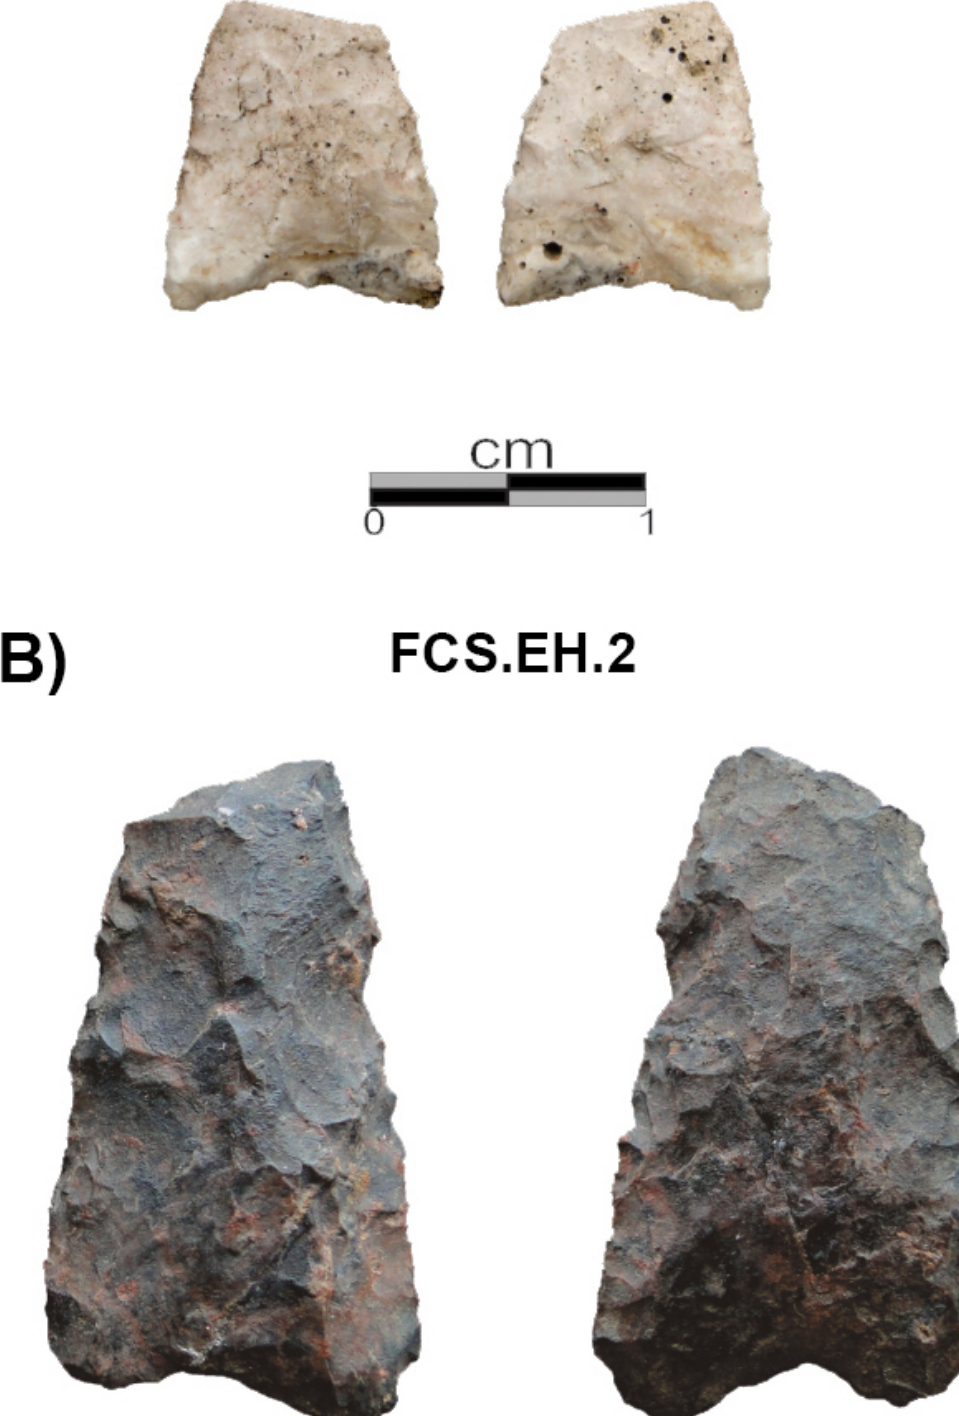
Figure 4. Darts manufactured on silicified limestone and